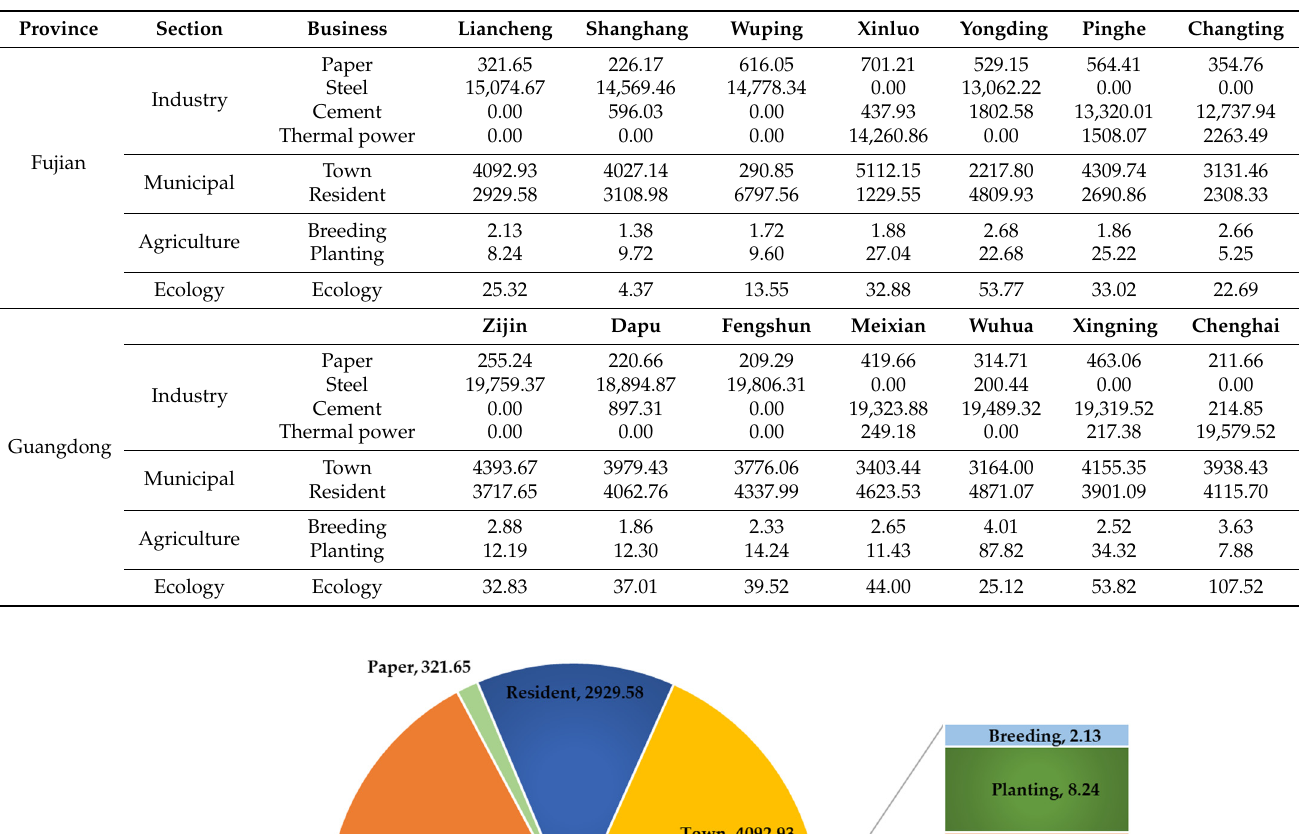
Table 2. The first-stage optimal water resources allocation scheme of different regions, industries, and sectors in the Tingjiang River basin based on the IFTSC model ( × 10 4 t).